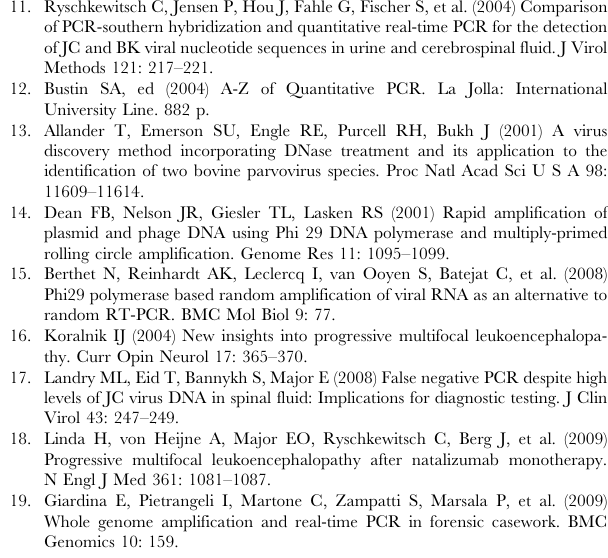
Figure S2 Over-saturated samples in Table 1 demon- strate typical sigmoid curves. Multicomponent view of over-saturated curves used in Table 1, demonstrating typical sigmoid curves with a Ct-value of 3–5. (A) dR view of results after 16 h Amp-PCR using a JCV standard containing 180 copies/ m l. (B) Multicomponent view of results after 16 h Amp-PCR using a JCV standard containing 180 copies/ m l. (C) dR view of results after ‘PCR only’ using a JCV standard containing 180 copies/ m l. (D) Multicomponent view of results after ‘PCR only’ using a JCV standard containing 180 copies/ m